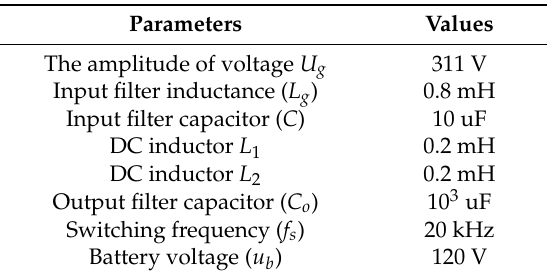
Table 3. Simulation